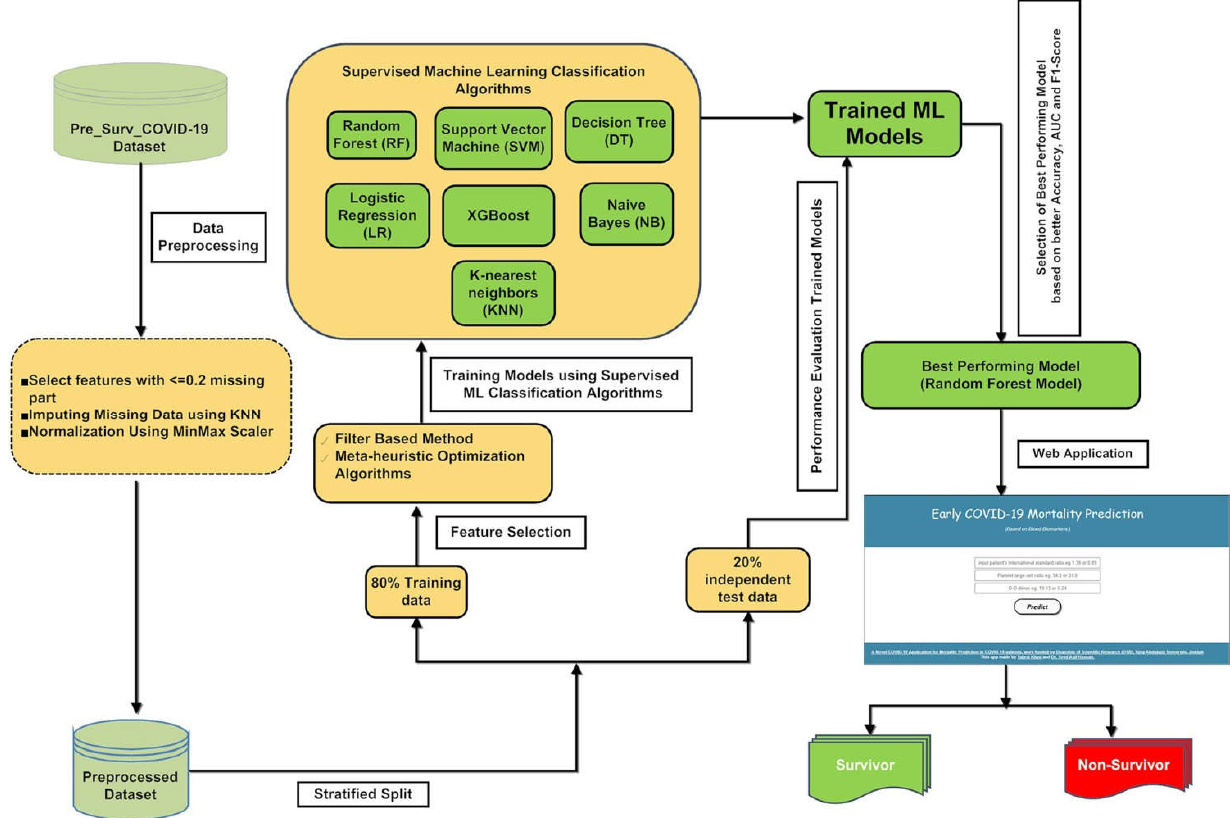
Figure 1. A pictorial representation of the ML pipeline for implementing an application that predicts the mortality of positive COVID-19 cases.